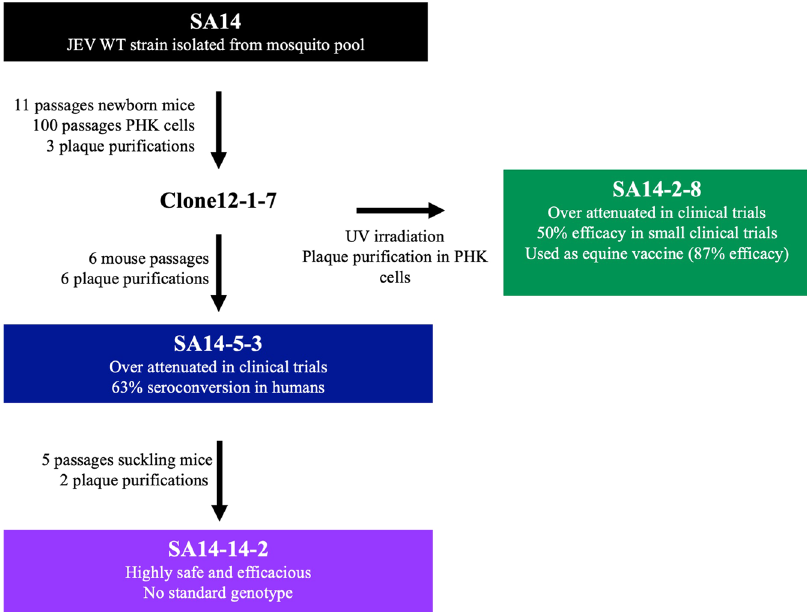
Fig. 1 Derivation of JEV vaccine strains. The successful SA14-14-2 vaccine strain was derived after multiple attempts to attenuate WT strain SA14. The fi rst of these attempts, Clone12-1-7, was generated by mouse and cell culture passage. It was then UV irradiated to generate SA14- 2-8 and further mouse passaged to generate SA14-5-3. Both of these vaccine strains were shown to be overly attenuated in humans so SA14- 5-3 was passaged in suckling mice which generated the currently utilized